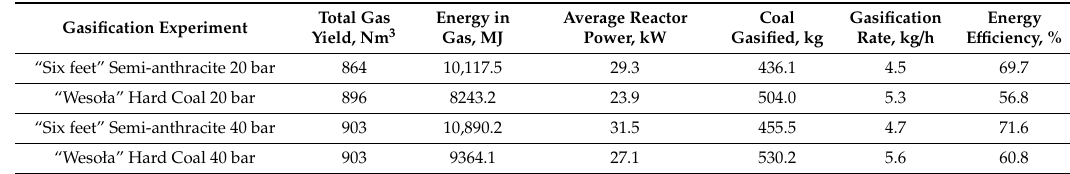
Table 5. Summary of the material and energy balance calculations for the four experiments conducted. Gasification